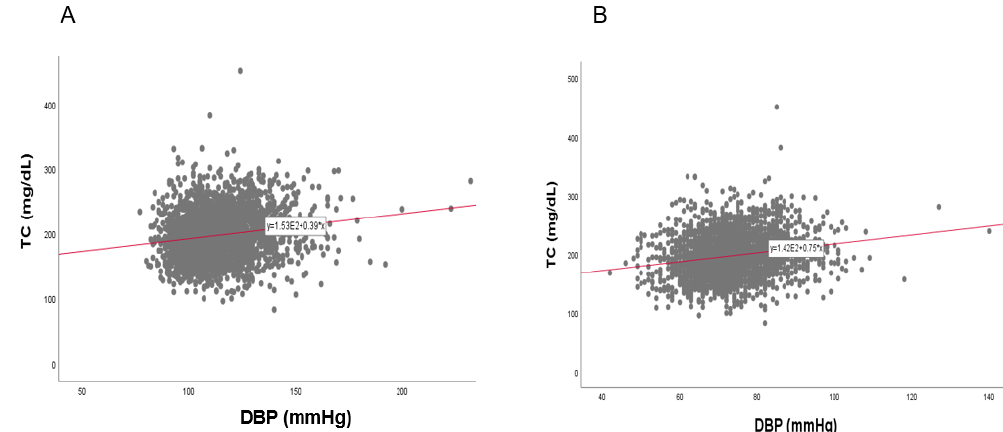
Figure 13. Pearson’s correlation analysis between total cholesterol (TC) and diastolic blood pressure (DBP) in men ( A ) and women ( B ). The men ( A ) showed r = 0.226 ( p < 0.001) and women ( B ) showed r = 0.192 ( p < 0.001) between DBP and